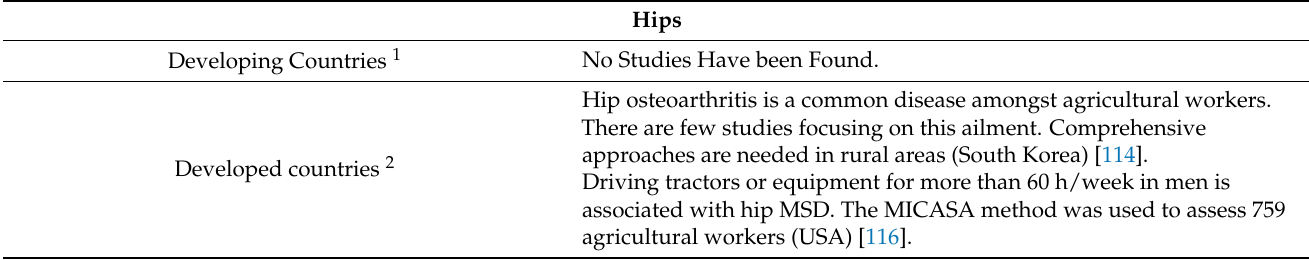
Table A4. MSD research in agriculture (1995–2020). Category: Hips.